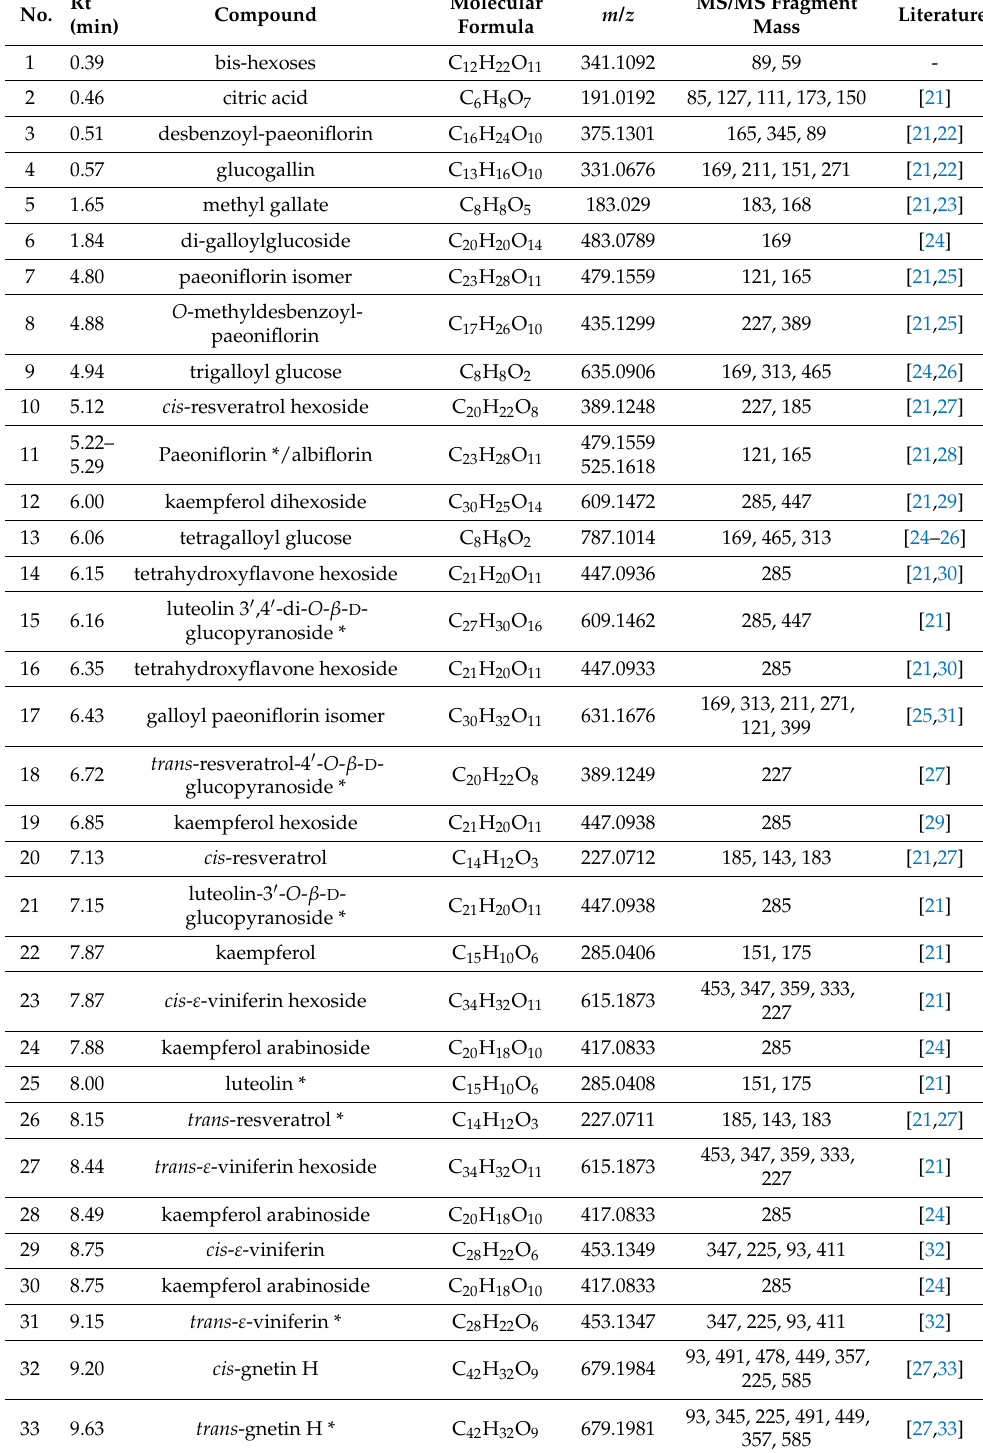
Table 1. Secondary metabolites of the BS methanolic extract of P. clusii subsp. Rhodia , determined using UHPLC-HRMS in negative